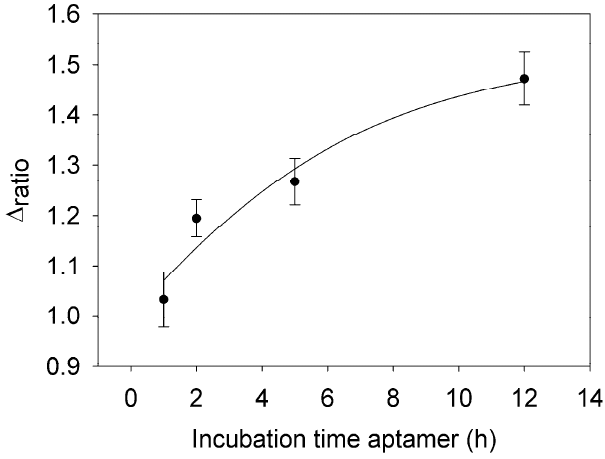
Figure 4. Optimization of the incubation time of aptamer using electrochemical grafting as immobilization